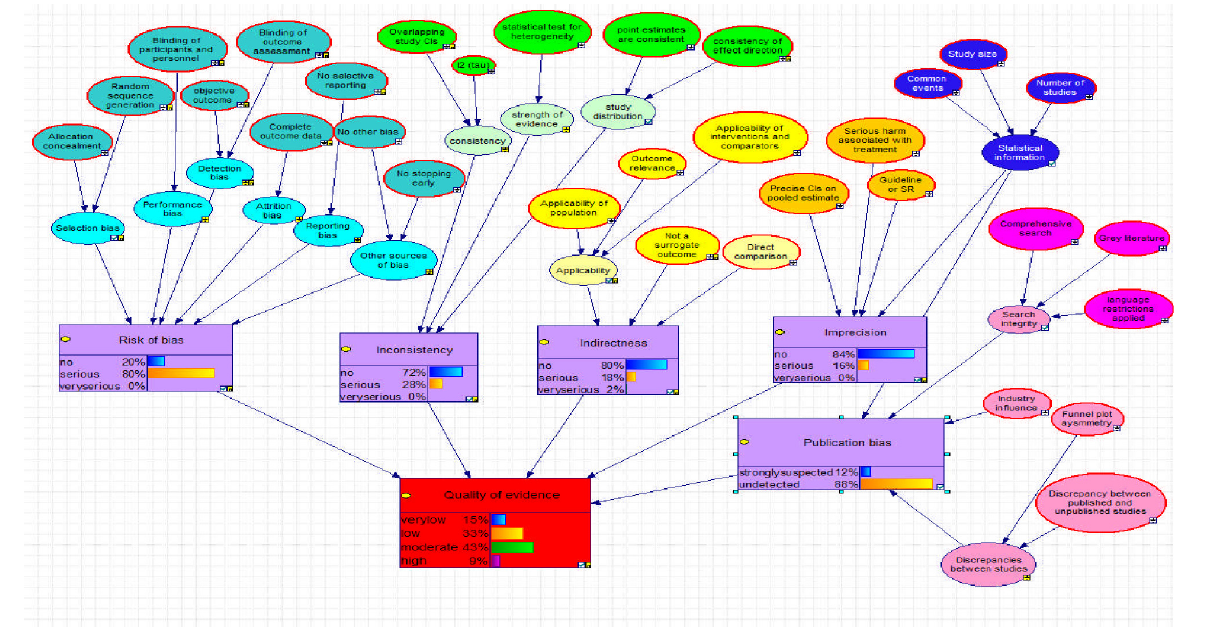
Fig 2. Example evidence profile with probability distributions from Bayesian